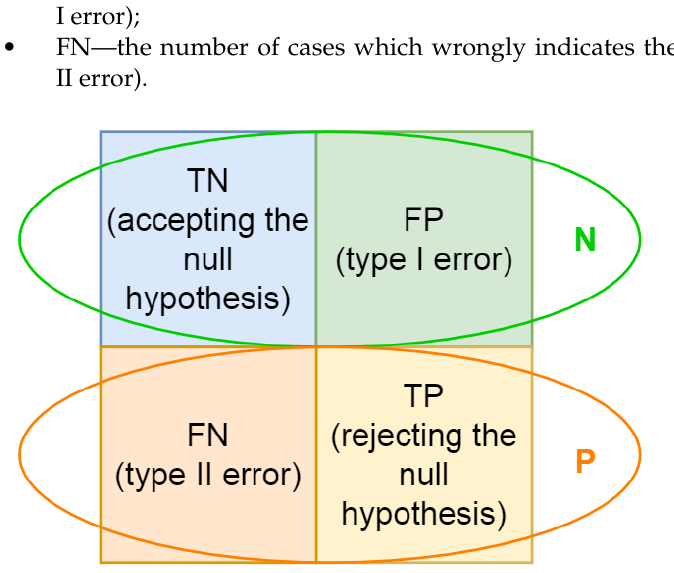
Figure 7. Confusion matrix for binary